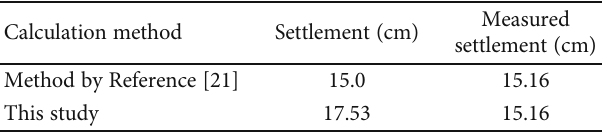
Table 2: Calculating results. Calculation method Settlement